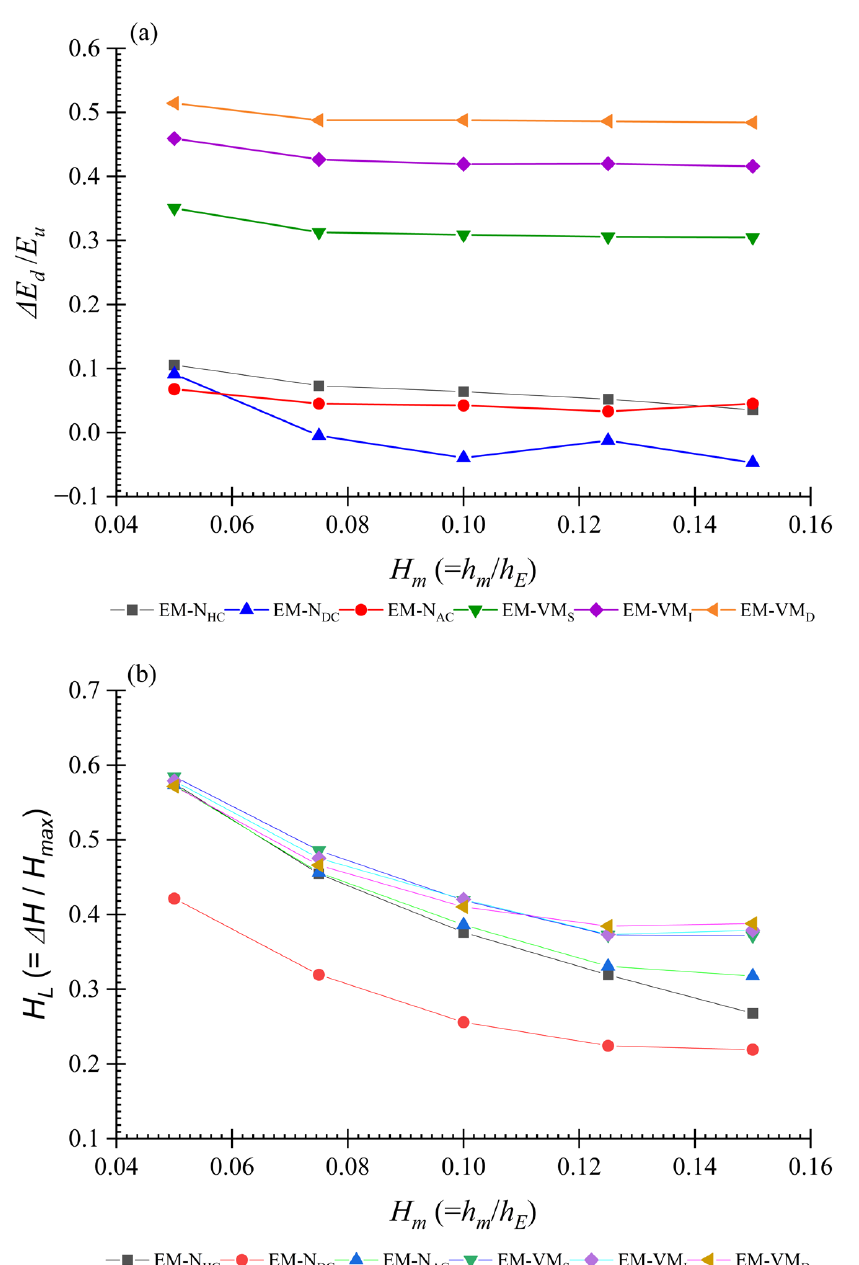
Figure 8. ( a ) Specific energy loss at the downstream brink edge of the EM with crest condition and varying the normalized overtopping depth ( H m ); ( b ) head loss at the downstream plunge pool concerning the normalized downstream brink edge water depth ( H d